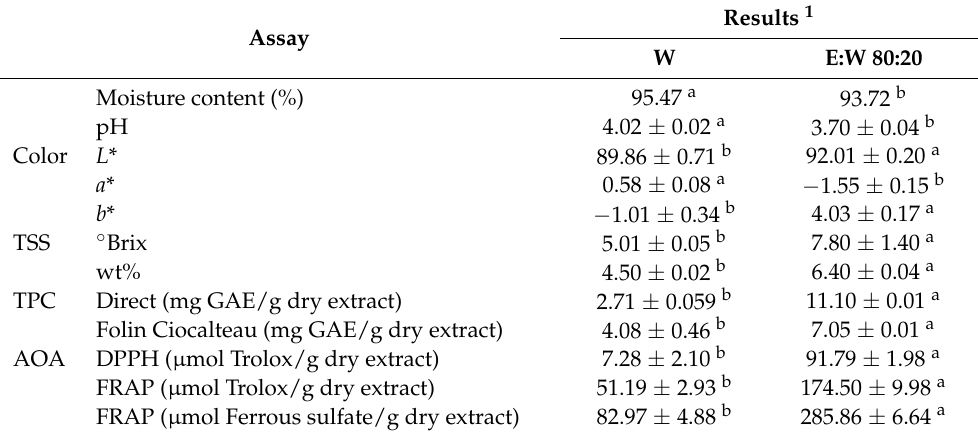
Table 3. Major physicochemical properties of water extract (W) and ethanol 80% extract (E:W 80:20) produced at ambient temperature. Assay